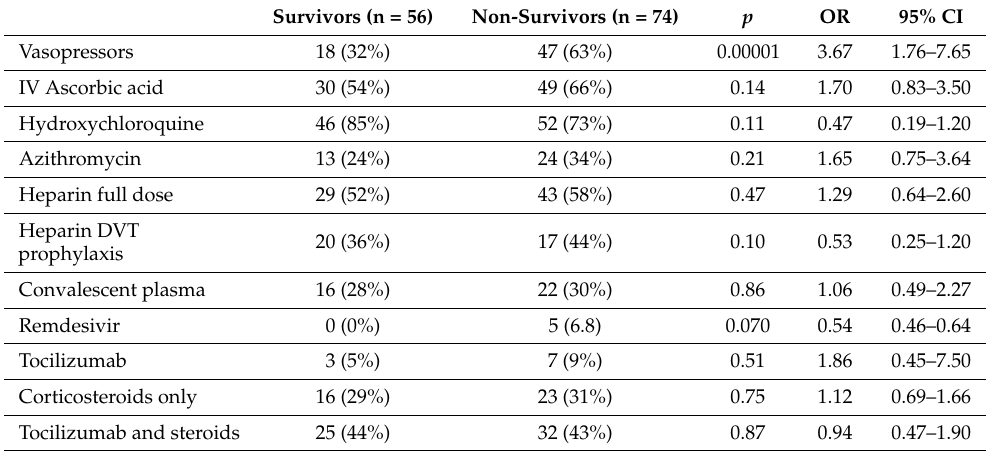
Table 10. Pharmacologic interventions in COVID-19 ICU survivors and non-survivors without AKI.